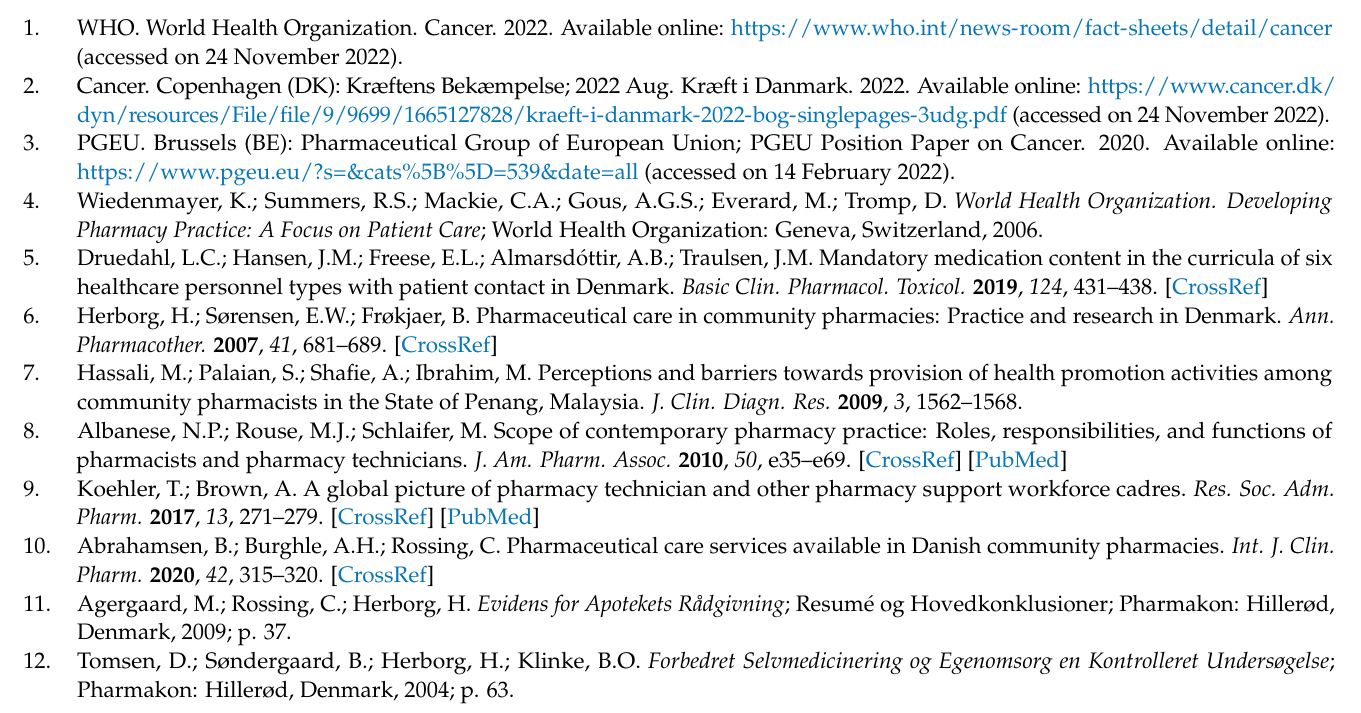
Figure 1. Potential barriers concerning counseling current or former cancer patients at a community pharmacy. Ratings are defined as: Agree and strongly agree. Neutral. Disagree and strongly disagree. (n = 134).